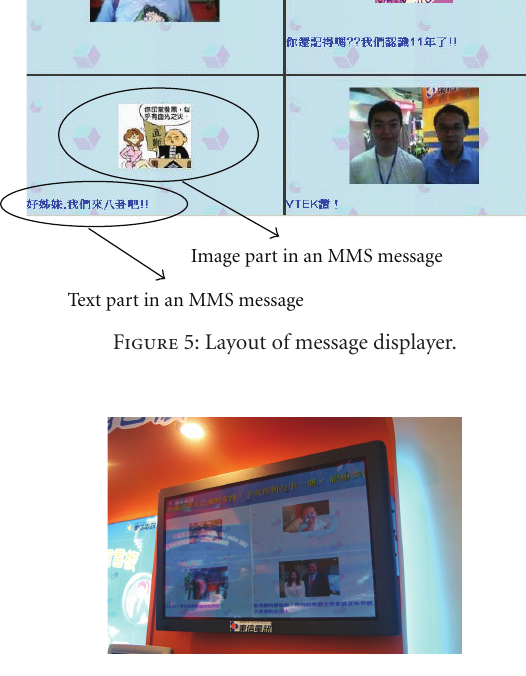
Figure 8: An M/M/1 Markov chain representation for the VSMMS message queue.